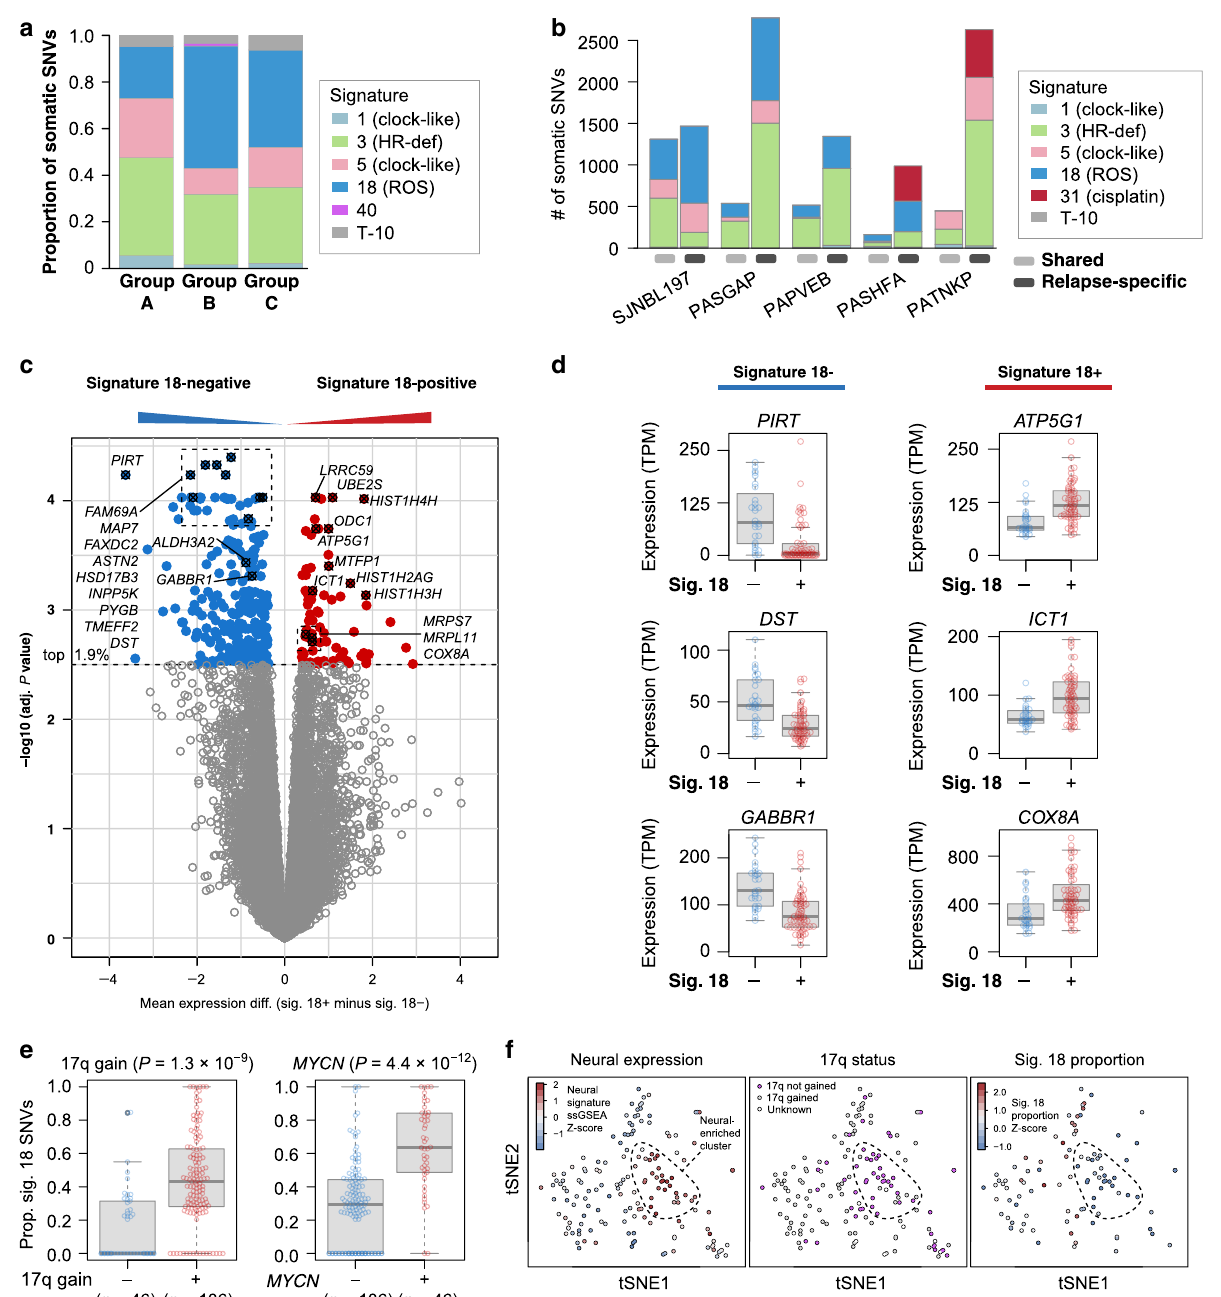
Fig. 4 Signature 18-induced mutational patterns. a Mutational signatures detected by WGS of 182 diagnosis samples, shown as proportion of mutations caused by the signature across all samples in each age group. Sample numbers are: group A, 39; B, 103; and C, 40. b Signature abundance in absolute SNVs is indicated on y -axis for fi ve patients with matched diagnosis and relapse samples. Shared mutations (present in both diagnosis and relapse, which are thus early mutations) are indicated at left, followed by relapse-speci fi c variants (detected only at relapse) on the right for each patient. c Differential gene expression analysis comparing signature 18-positive ( n = 60) vs. signature 18-negative ( n = 28) samples in 88 diagnosis samples with both WGS and RNA-Seq using Limma. Y -axis represents -log 10 P values; x -axis represents the log expression fold-change (mean expression difference), with genes increased in signature 18-positive samples in the positive direction (red) and genes increased in signature 18-negative samples in the negative direction (blue). Each point represents one gene, and genes with the lowest 1.9% of adjusted P values are shown in color. d Y -axis represents indicated gene ’ s expression in TPM, comparing signature 18-negative ( n = 28) and -positive ( n = 60) samples. Box, interquartile range (25th to 75th percentile); middle bar, median. Whiskers are described in R boxplot documentation (a 1.5 × interquartile range rule is used). e Proportion of SNVs caused by signature 18 in 182 diagnosis samples with WGS, comparing samples with vs. without 17q gain; or with vs. without MYCN alterations. Interquartile range, median, and whiskers are as in d . P values are by two-sided Wilcoxon rank-sum test. f t-SNE of 158 diagnosis and relapse samples with RNA-Seq (left two panels) or the subset of these with WGS ( n = 96, far right). Overlaid are, from left to right: (1) ssGSEA Z -scores for the neural gene set (Supplementary Table 2) with red indicating more neural expression, (2) the 17q gain status with purple indicating no gain, and (3) proportion of mutations caused by signature 18 in each sample ( Z -scores). Dotted outline is to enable comparison of a neural-enriched group between each plot. Source data are provided as a Source Data fi